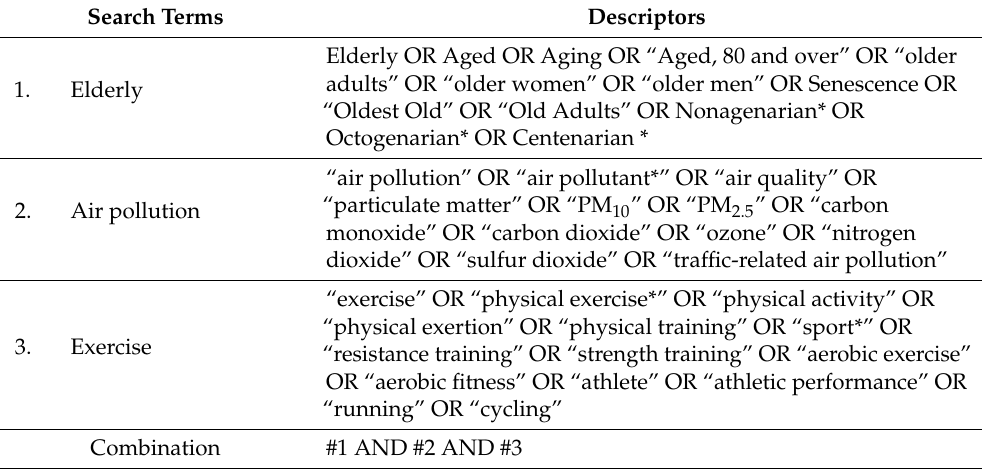
Table 1. Search strategy adopted for the mapping review.